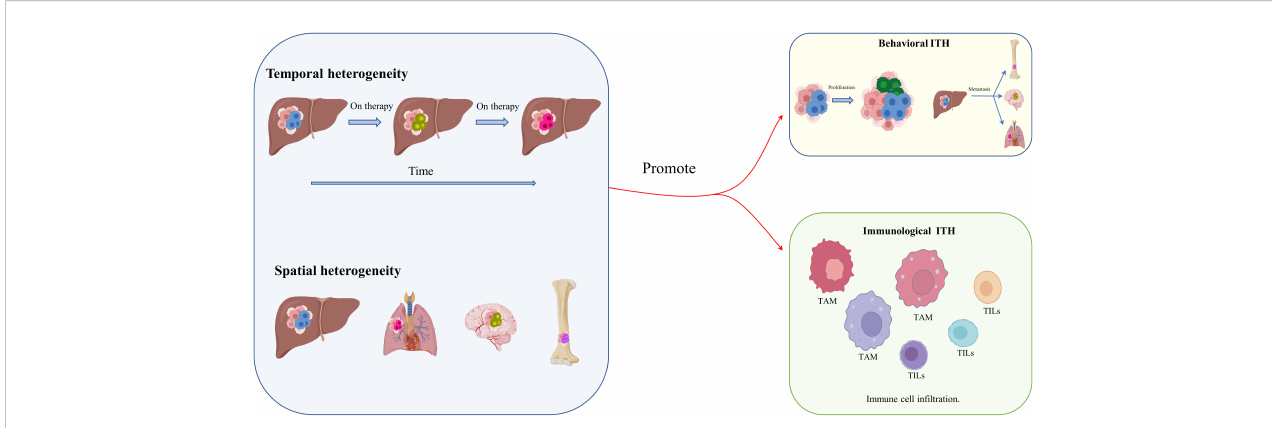
FIGURE 2 Behavioral and immunological ITH in HCC. Spatiotemporal remodeling of the TME, and especially of its metabolic and immunological components, promotes behavioral and immunological